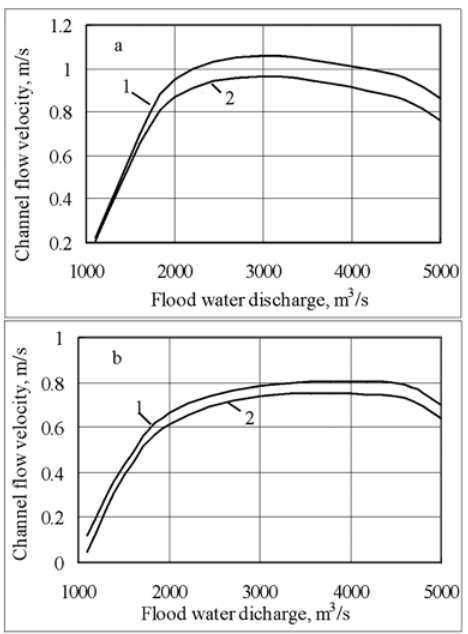
Fig. 11. Water velocities developing in the channel, when its depth is: 3 m (graph a), 2.5 m (graph b), and when the width of channel is: 1 – 100 m; 2 – 160